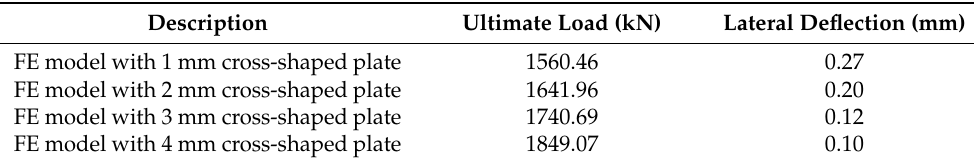
Table 5. Summary of ultimate load-bearing capacity and lateral deflection of the FE models of CCFST with different thickness of the cross-shaped plate.